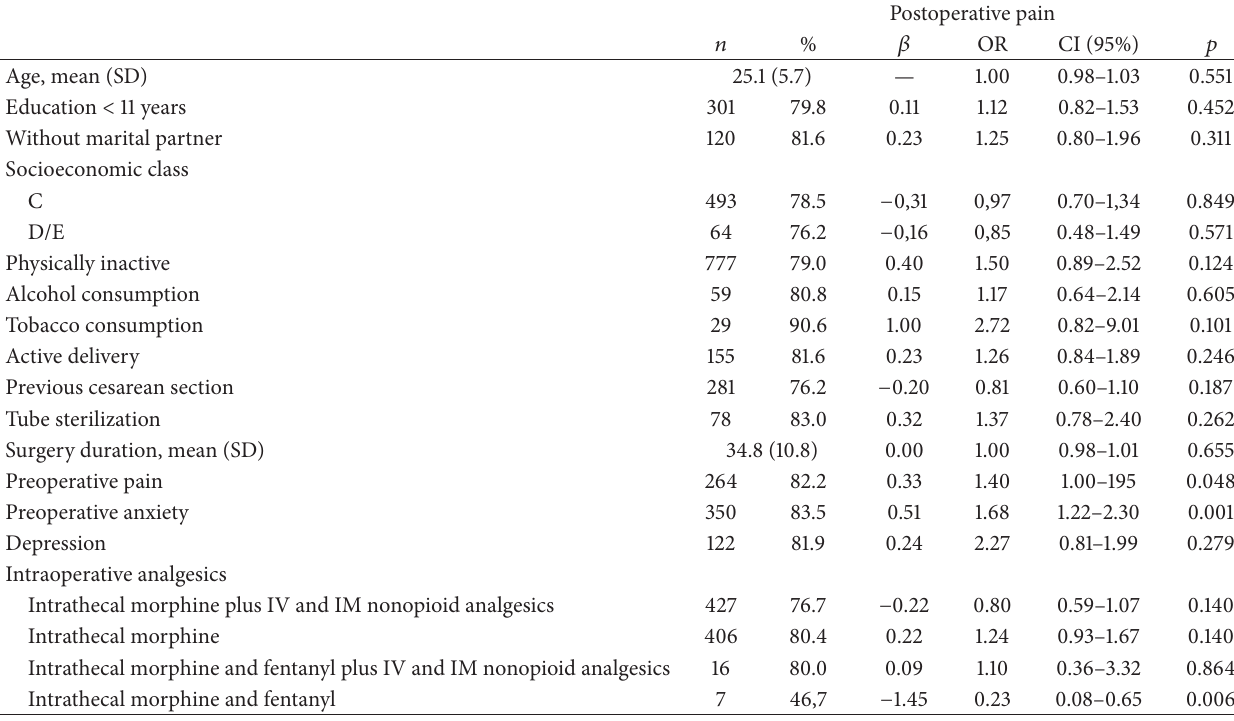
Table 3: Univariate analysis of potential predicting factors of moderate to severe postoperative pain.